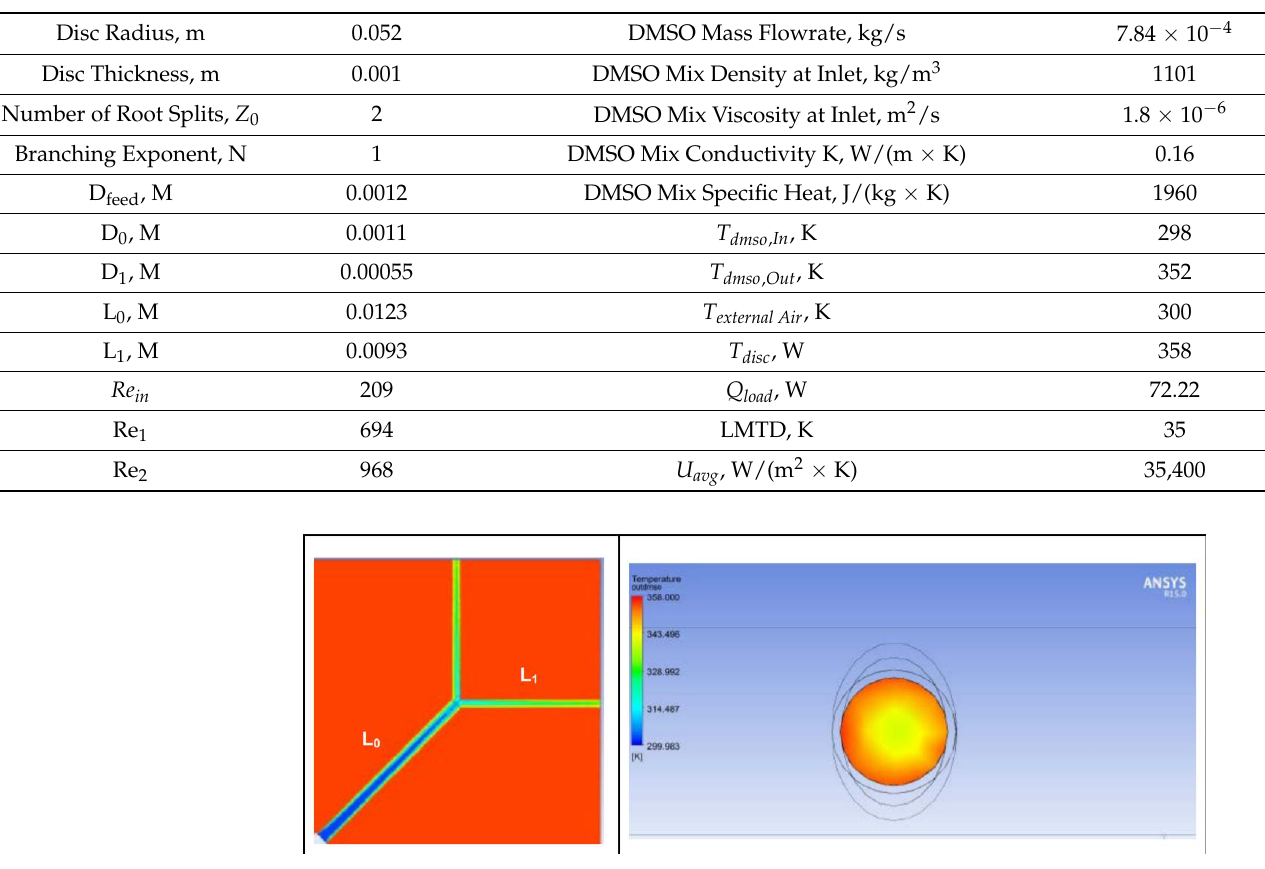
Figure 9. Ultra-micro DSHE: Results of a RANS CFD simulation (Adapted from Ref. [10]).